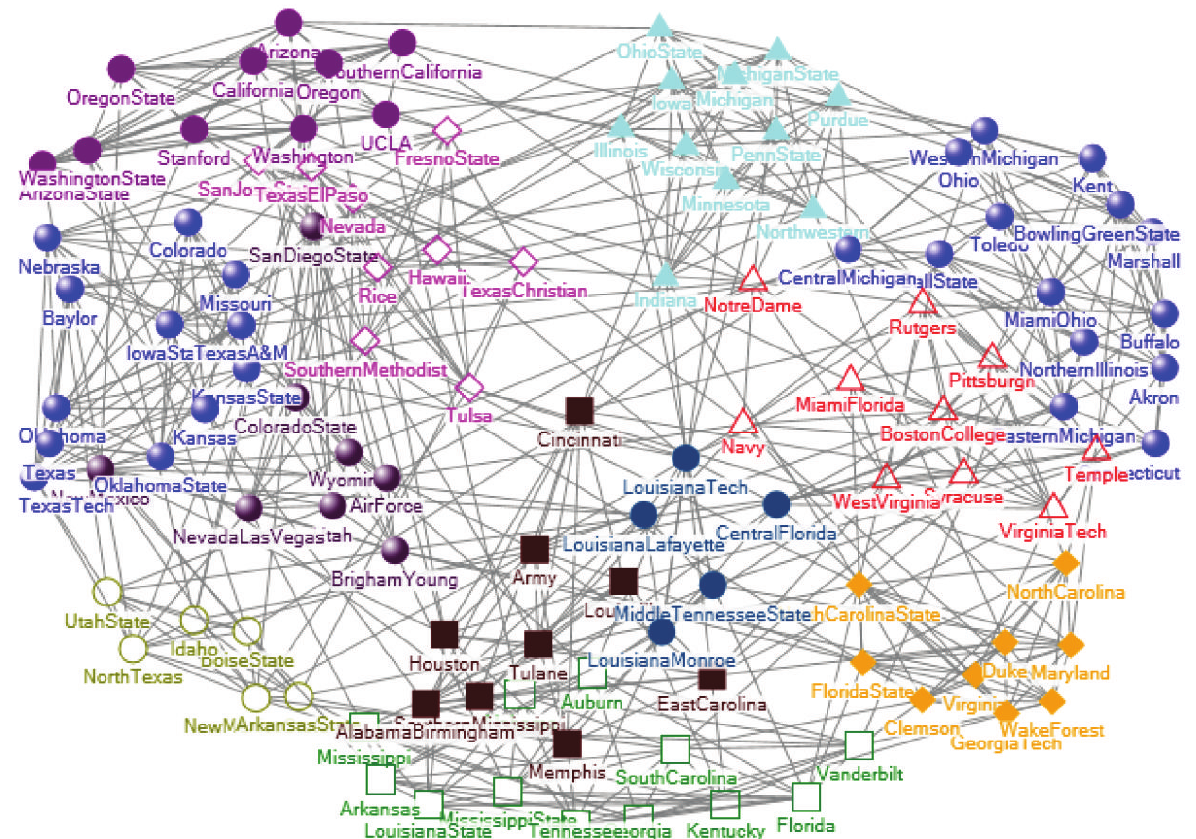
Figure 5: The community detection results by the traditional spectral algorithm.